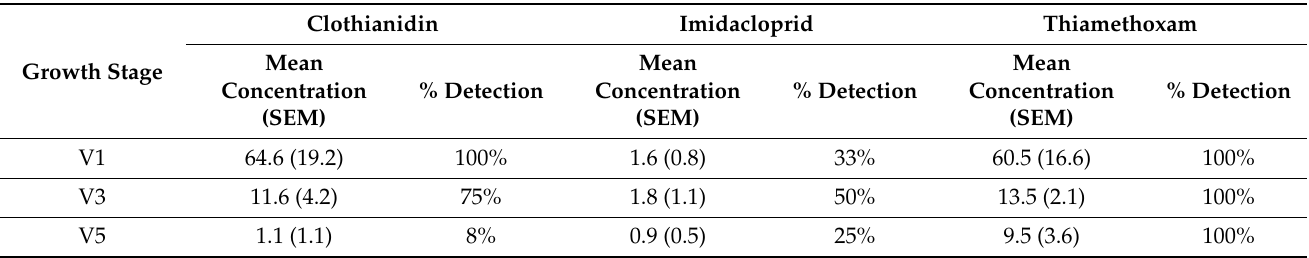
Table A2. Mean concentration (ng/g) and percent detection detected in corn leaf tissue from untreated plots at each sampled growth stage across all